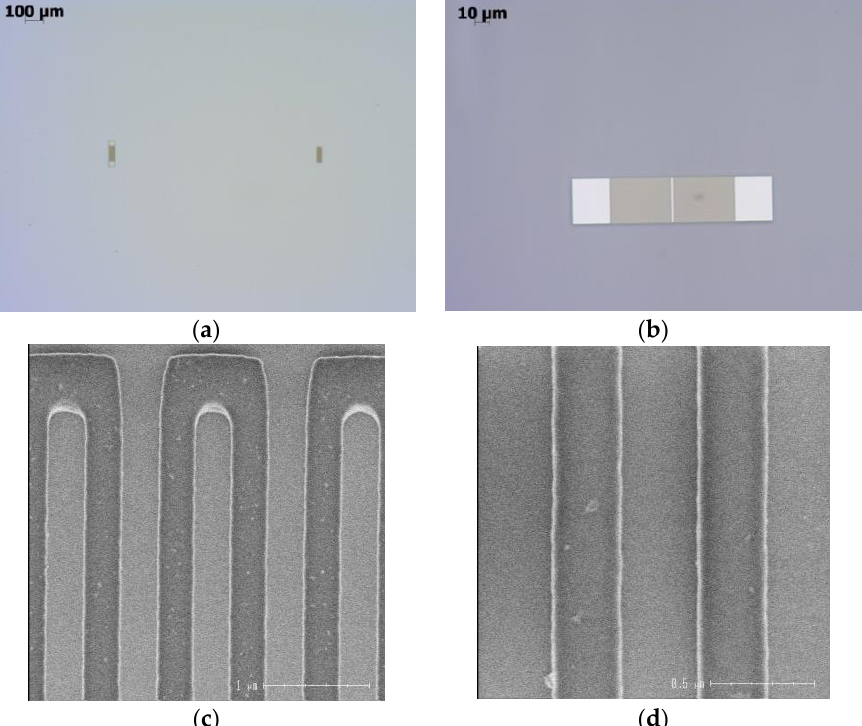
Figure 2. IDT and reflector R1, after first front-end manufacturing sequence: ( a ) large view of the IDT and reflector R1(optical microscopy); ( b ) closer view of the IDT. Only the fingers and bus bars were manufactured, at this stage; ( c ) Critical Dimension-Scanning Electron Microscopy (CDSM) view of the IDT, after lift-off; ( d ) closer CDSM view of the IDT fingers.